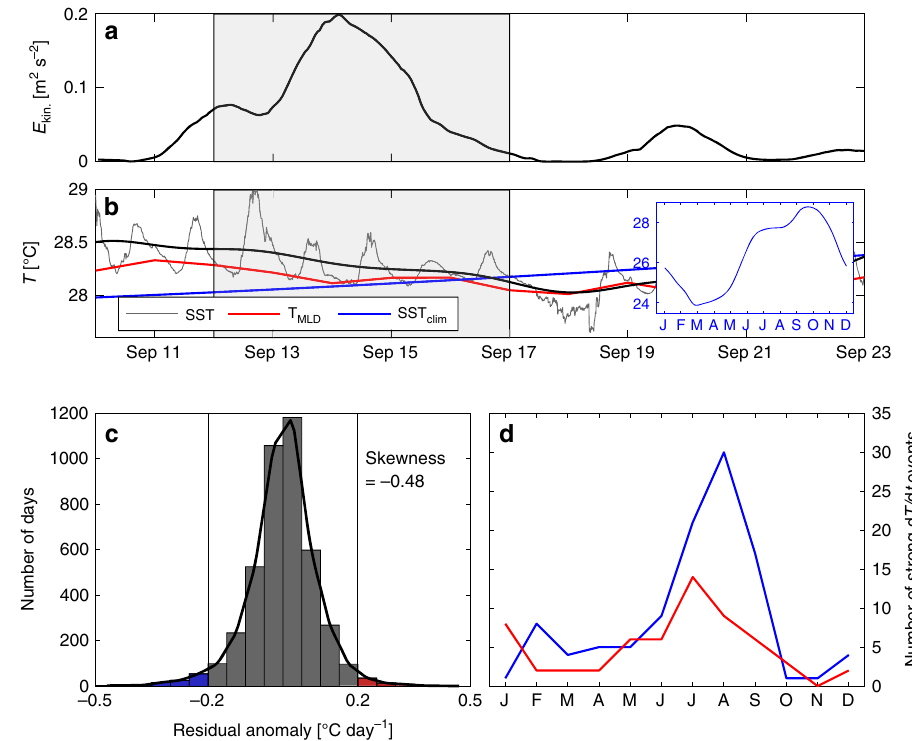
Fig. 7 Temperature evolution and statistics of daily changes at 11.5°N, 23°W. a Total kinetic energy derived from the slab model around the near inertial wave (NIW) event (similar to Fig. 5d; gray shading indicates the time de fi ned around the NIW event for the local balance). b Sea surface temperature (SST) time series from the PIRATA buoy at 11.5°N, 23°W around the NIW event (gray line) together with the low-pass fi ltered SST time series using a 3- day Hanning window (black line), the ePIRATA mixed layer (ML) temperature (red line), and the SST climatology (blue line). The SST climatology for the (cid:1) (cid:3) full year is shown in the insertion. c Distribution of daily temperature change anomalies ∂ T ∂ t converted from ePIRATA heat budget residuals (June 2006 – December 2017). d Seasonal cycle of strong ML cooling and warming events ( ∂ T ∂ t < (cid:2) 0 : 2 °C day − 1 in blue and ∂ T ∂ t > 0 : 2 °C day − 1 in red) from the ePIRATA daily temperature change anomalies used in c